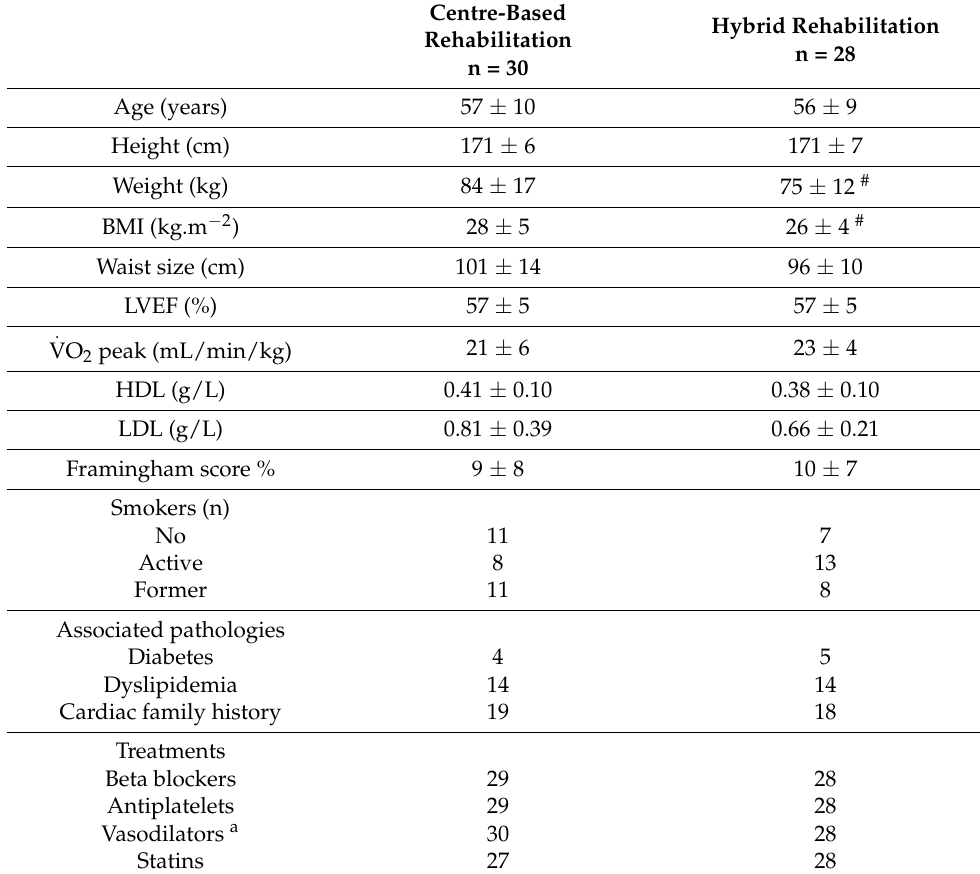
Table 1. Patient characteristics at